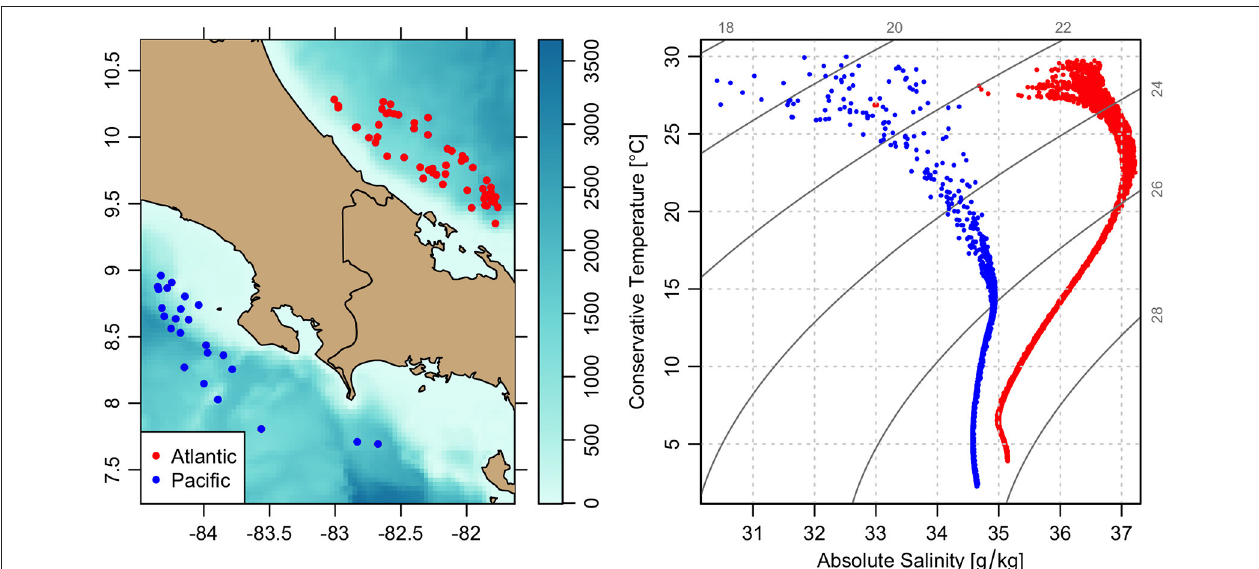
FIGURE 5 | Contrast of water properties across the Isthmus of Panama. (Left) Locations of Argo cycles, color-coded by ocean. (Right) Temperature-salinity diagram showing the contrast between Atlantic and Pacific watermasses.